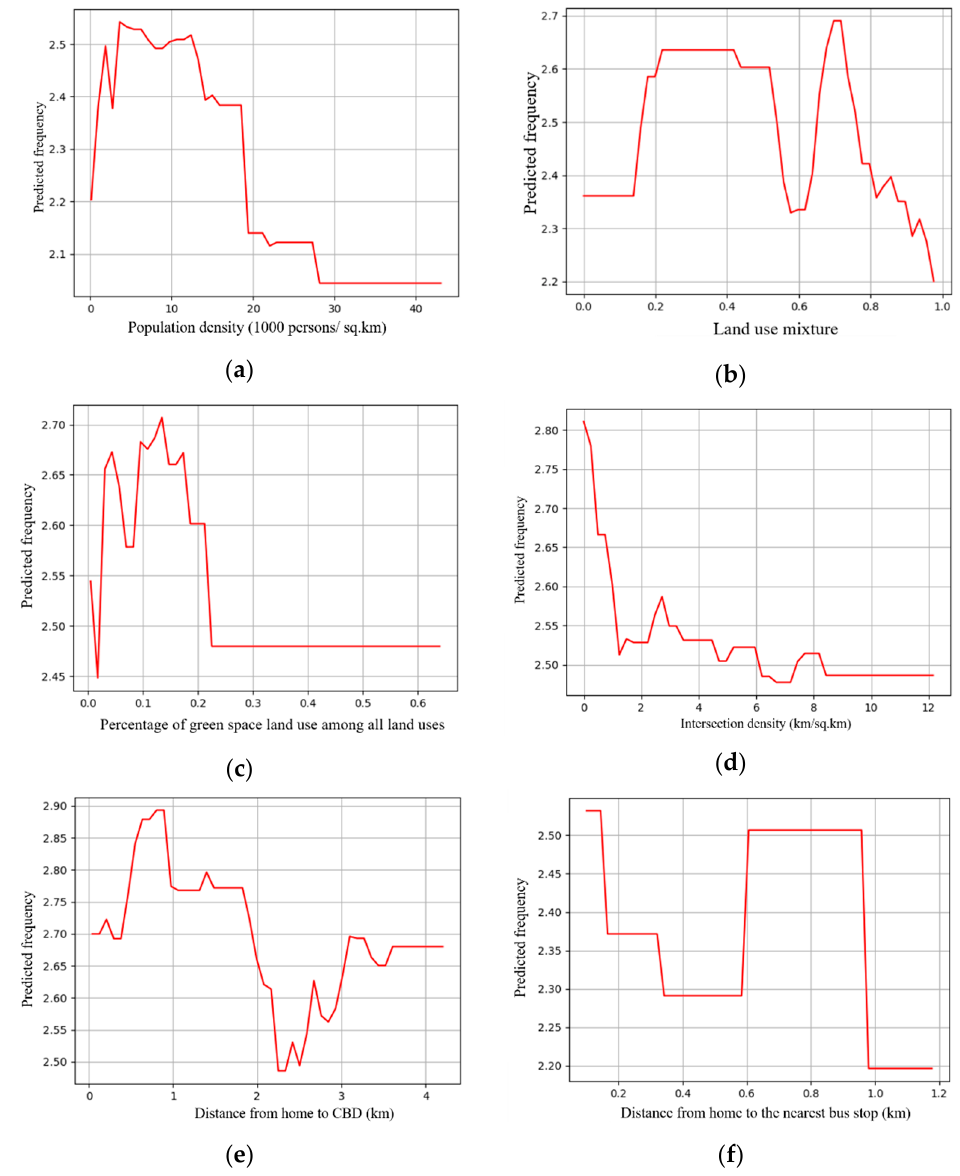
Figure 3. ( a ) Association between population density and frequency; ( b ) association between land- use mixture and frequency; ( c ) association between percentage of green space land use among all land uses and frequency; ( d ) association between intersection density and frequency; ( e ) association between distance from home to CBD and frequency; ( f ) association between distance from home to the nearest bus stop and frequency.